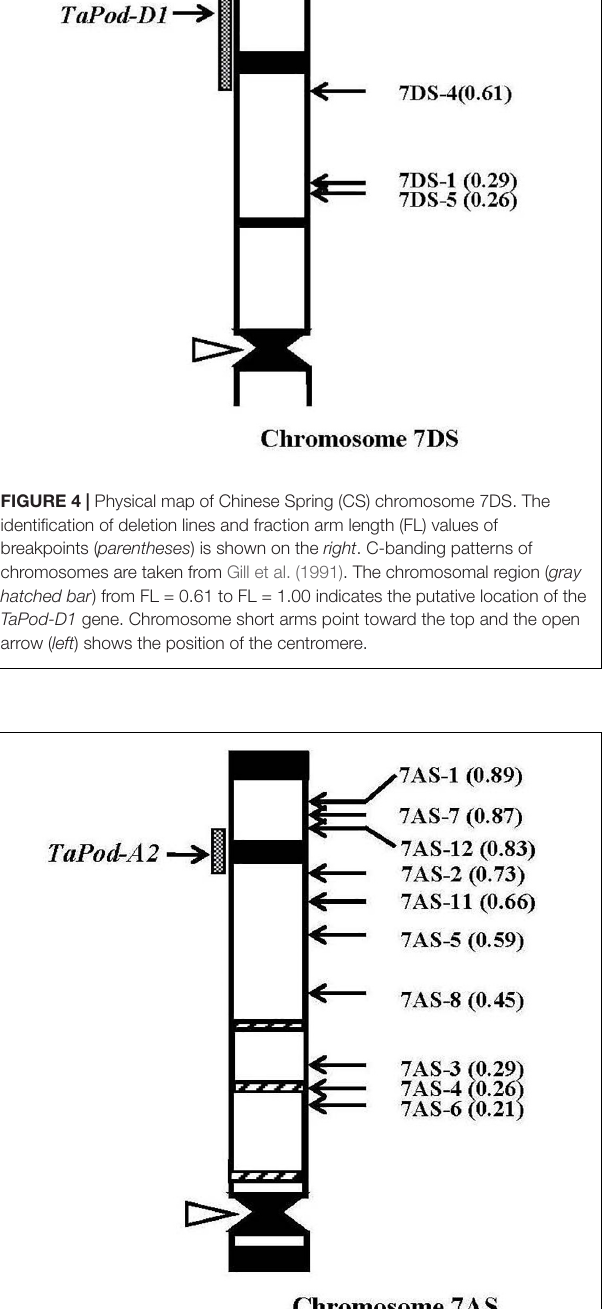
TABLE 2 | The PCR amplification POD genes in Chinese Spring group-7 ditelosomic lines and deletion lines. Line FL values